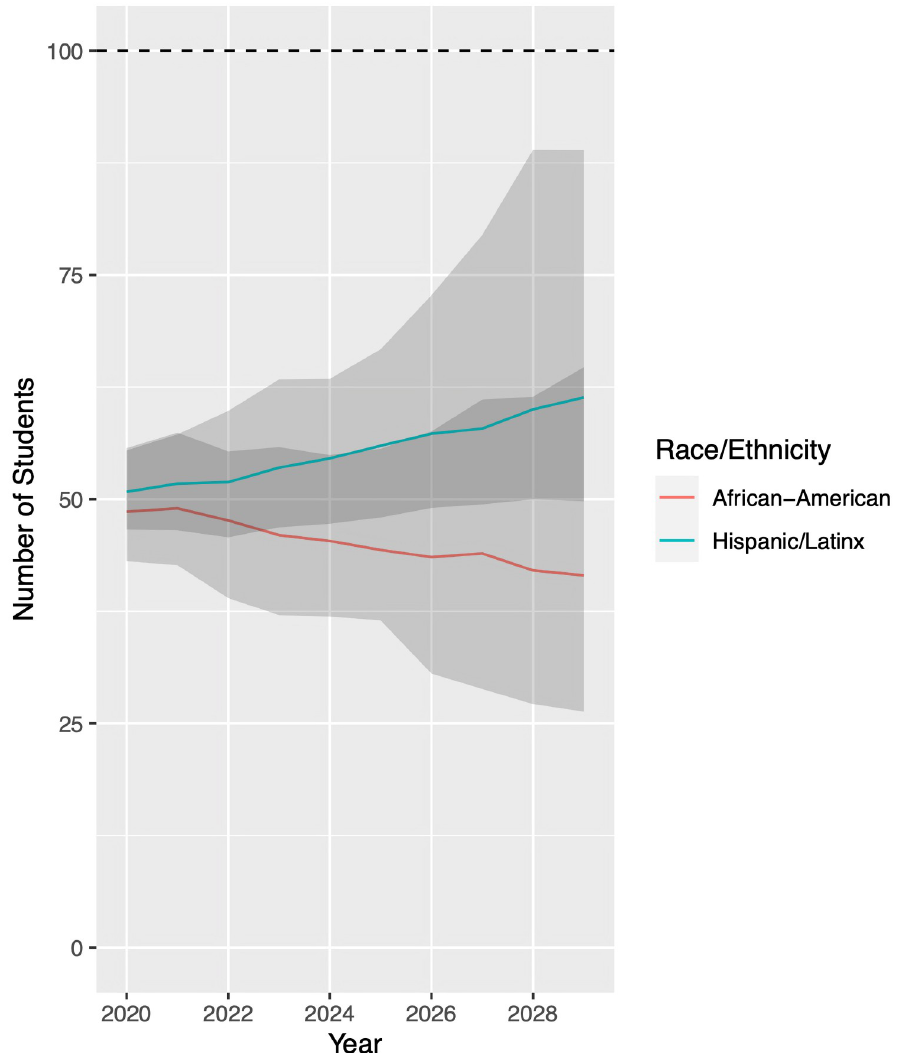
Fig 9. Critical mass index ( CMI ) projections for University of California-Berkeley. For each racial/ethnic group, CMI measures the enrollment of students (as predicted by our model) relative to the enrollment of students that would constitute a class representative of the applicant pool, which is defined in Eq (18). For every 100 Black students that UCB should enroll for critical mass, true enrollment will decrease over time (red curve). For every 100 Hispanic/Latinx students that UCB should enroll for critical mass, true enrollment will increase (blue curve). Still, we project that neither group will reach critical mass over the next decade. Grey bands indicate 95% confidence